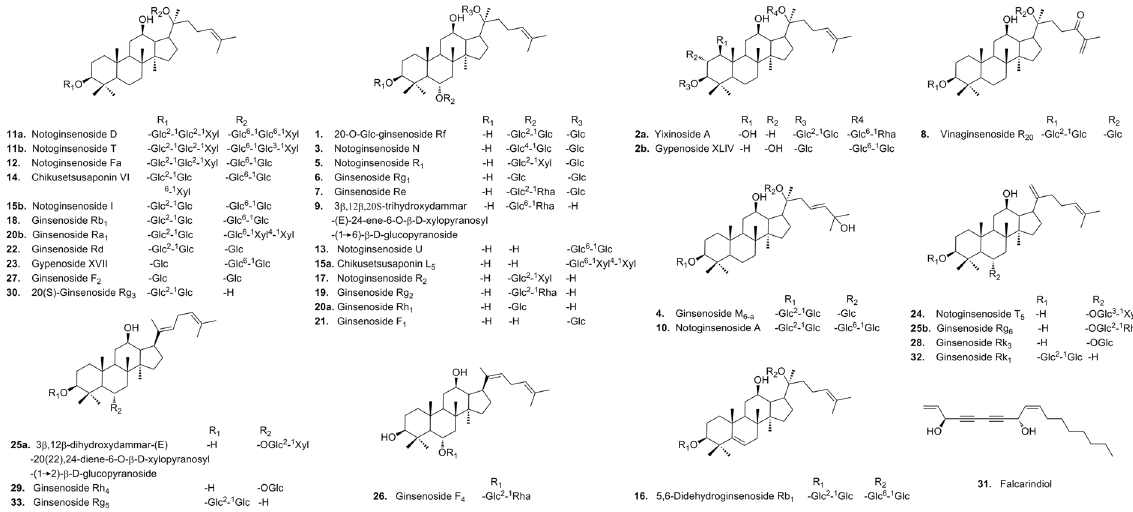
Figure 2. Typical chemical structures of constituents in